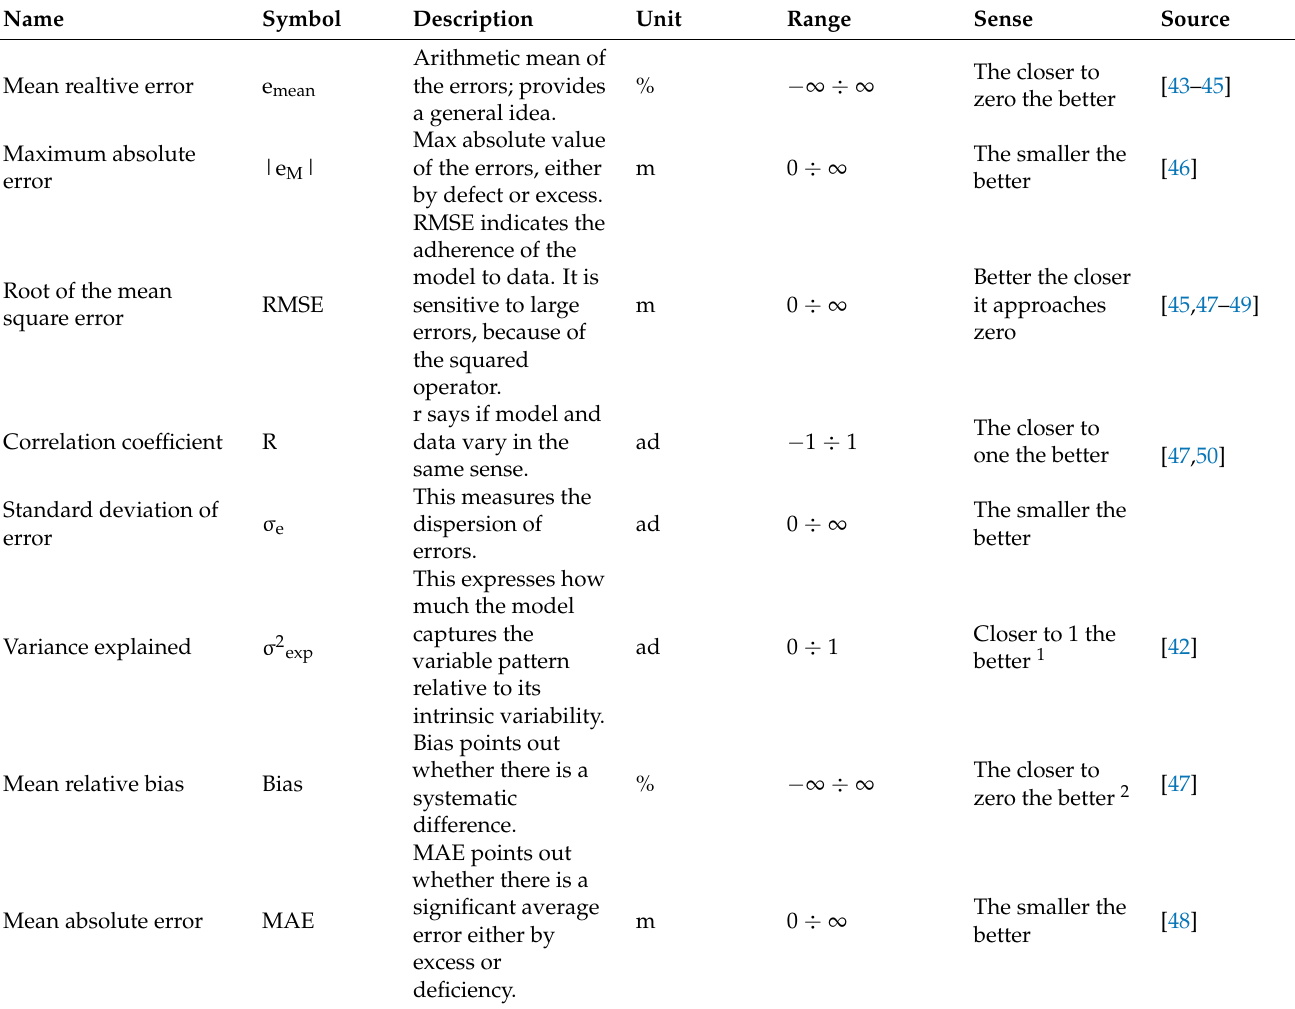
Table 3. Indicators of fitting